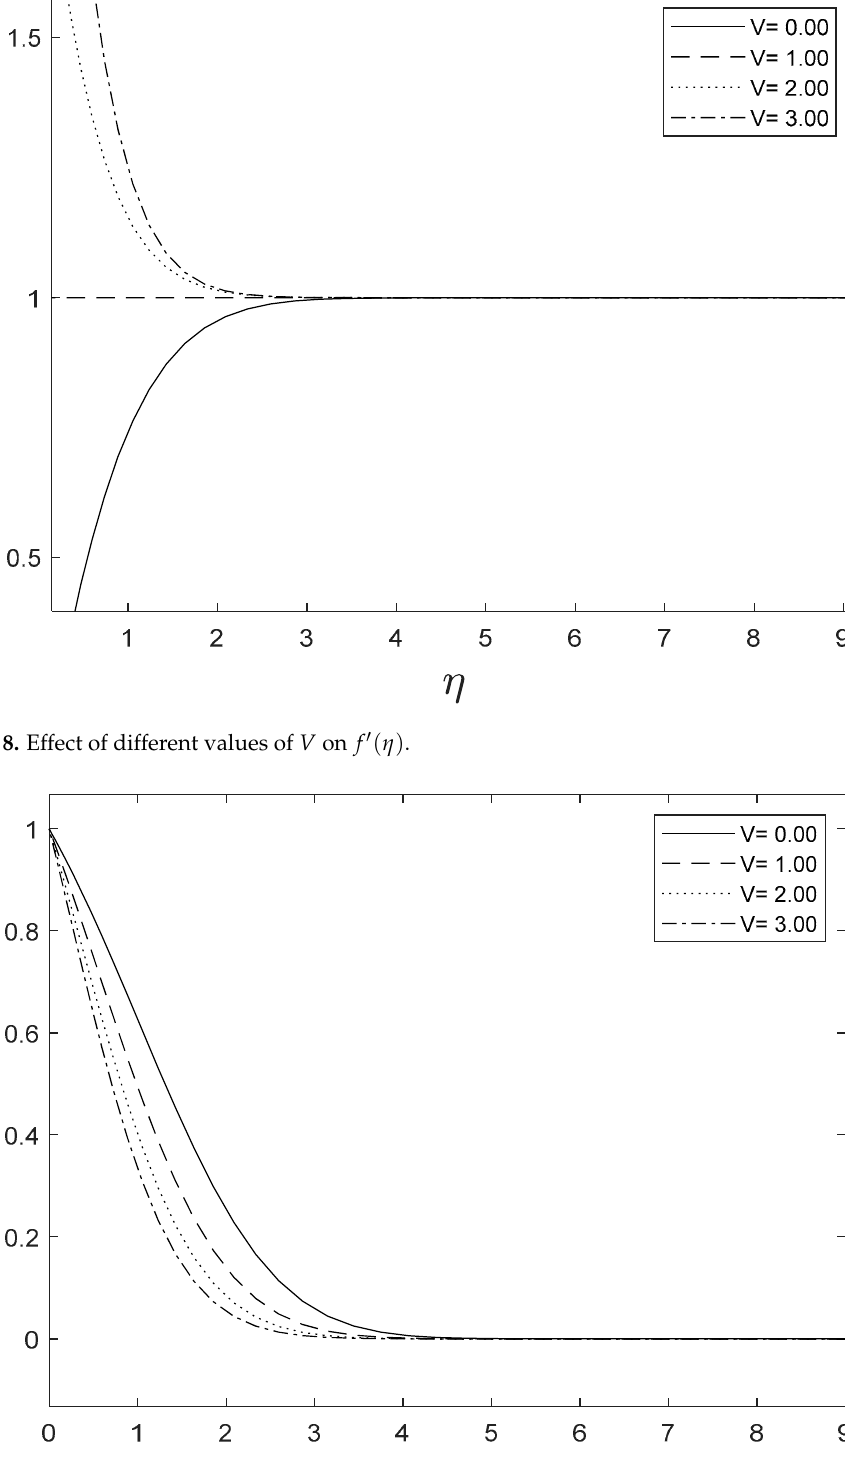
Figure 9. Effect of different values of V on θ ( η )